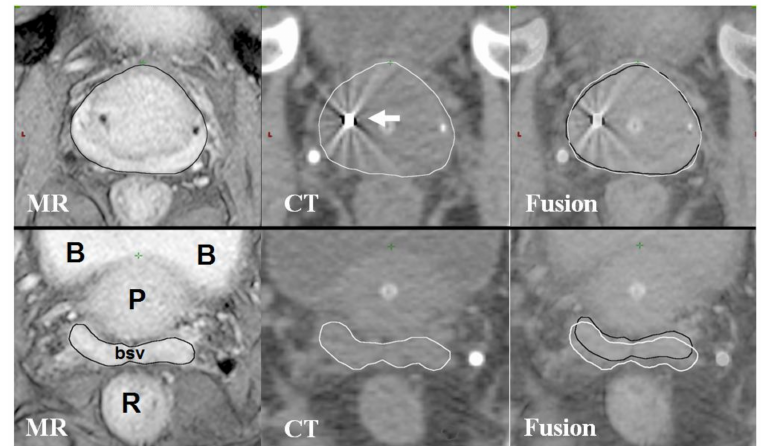
Figure 2. MR and CT fusion for prostate contouring.Axial MR and CT images at the level of the prostate (upper three images) and base of seminal vesicles (lower three images). B, bladder; P, prostate; bsv, base of seminal vesicles; R, rectum. White arrow shows gold fiducial marker on CT image. MRI-based contours are in black, CT-based contours are in white. The upper three images demonstrate good fusion of prostate MRI and CT imaging; lower three images from the same patient showing less accurate fusion at the base of seminal vesicles. The difference in position of bsv can be seen in the fusion images where contours from MRI (black) and CT (white) are shown